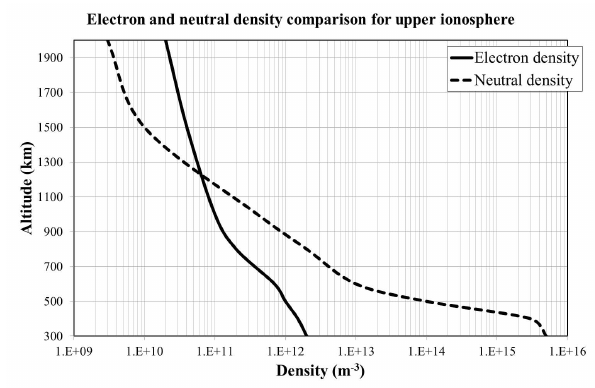
Fig. 1. Electron and neural density trends for upper